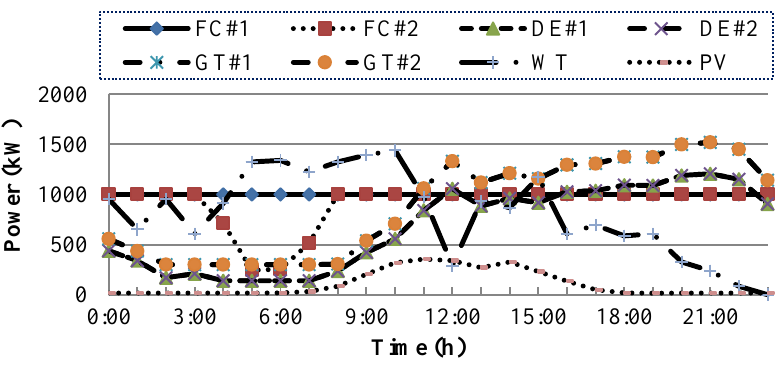
Figure 15. Numerical results for the optimal generation of each DG under autonomous